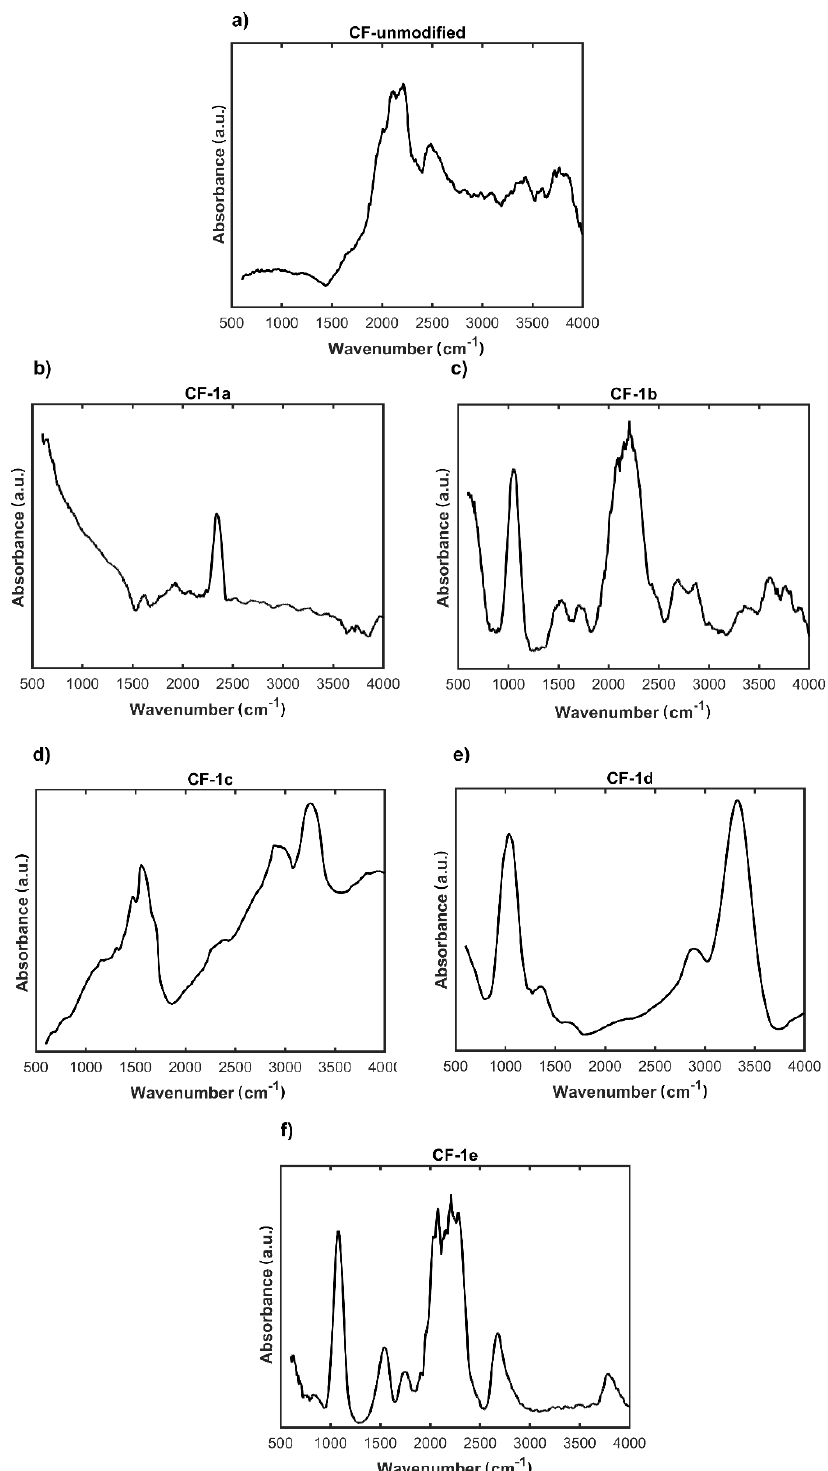
Figure 4. FTIR spectra of: ( a ) unmodified carbon nonwoven ( CF ); ( b ) carbon nonwoven fabric modified with 4-bromoaniline ( CF-1a ); ( c ) carbon nonwoven fabric modified with 4-chloroaniline ( CF-1b ); ( d ) carbon nonwoven fabric modified with 4-aminobenzoic acid ( CF-1c ); ( e ) carbon nonwoven fabric modified with 1,4-diaminobenzene ( CF-1d ); ( f ) carbon nonwoven fabric modified with 4-aminophenol ( CF-1e ).